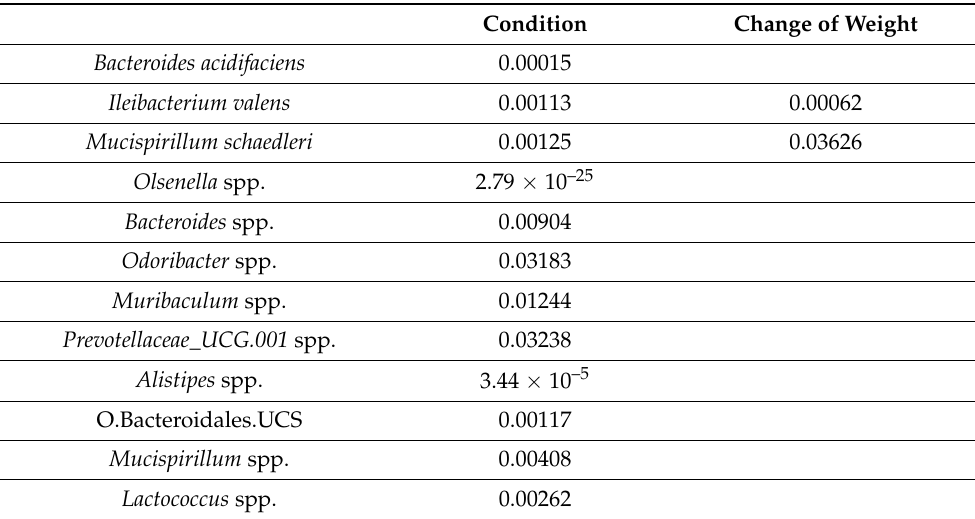
Table 2. Summary of the p -values corresponding to the 32 significantly differentially abundant taxa at species level according to both Condition and Change of weight